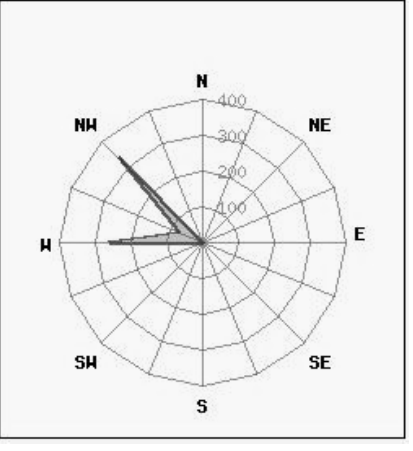
Fig 9 . Wind rose (2006-09-06 0–11 h) 4. Išvados